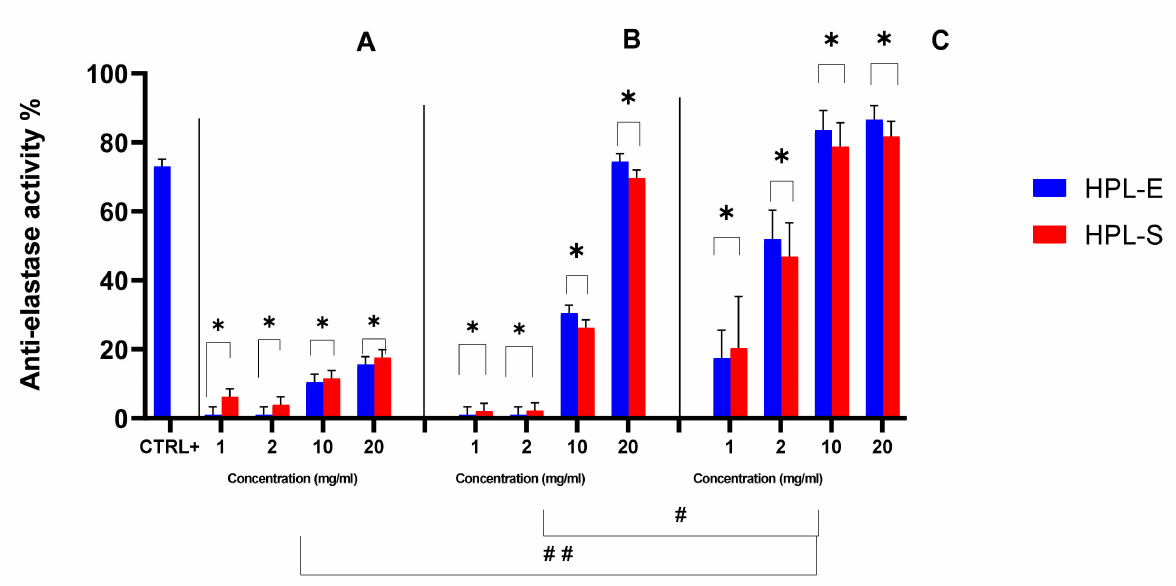
Figure 5. Anti-elastase activity percentage of freeze-dried MSC-secretome obtained from BM cell lines 1 ( A ), 2 ( B ), and 3 ( C ) expanded in HPL-S or HPL-E. CTR +: EGCG at 0.6 mg/mL in deionized water. Multifactor ANOVA, mean values ± LSD, n = 3 are reported. * indicates a significant difference between the means ( p < 0.05) between HPL-E and HPL-S, while # and ## indicate a significant difference between the means of the experiments (respectively, with a p < 0.05 and p <